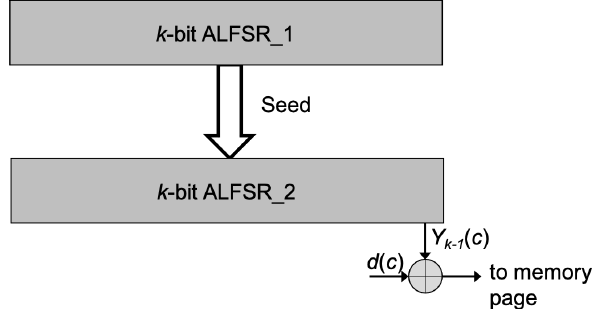
Figure 7. Proposed scheme for data randomization. For each memory page, ALFSR_1 generates the seed initializing ALFSR_2 whose content is used to randomize the data to be stored. k = (cid:100) log